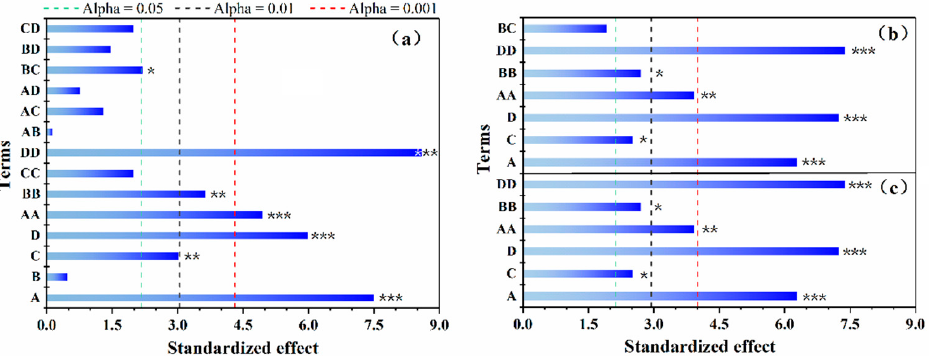
Figure 3. The pareto diagram of standardized effects on the TN removal of the ( a ) initial model, ( b ) first modified model, and ( c ) second modified model. (A) C/N, (B) shaking speed, (C) inoculation level, and (D) pH. * p < 0.05, ** p < 0.01, and *** p < 0.001.